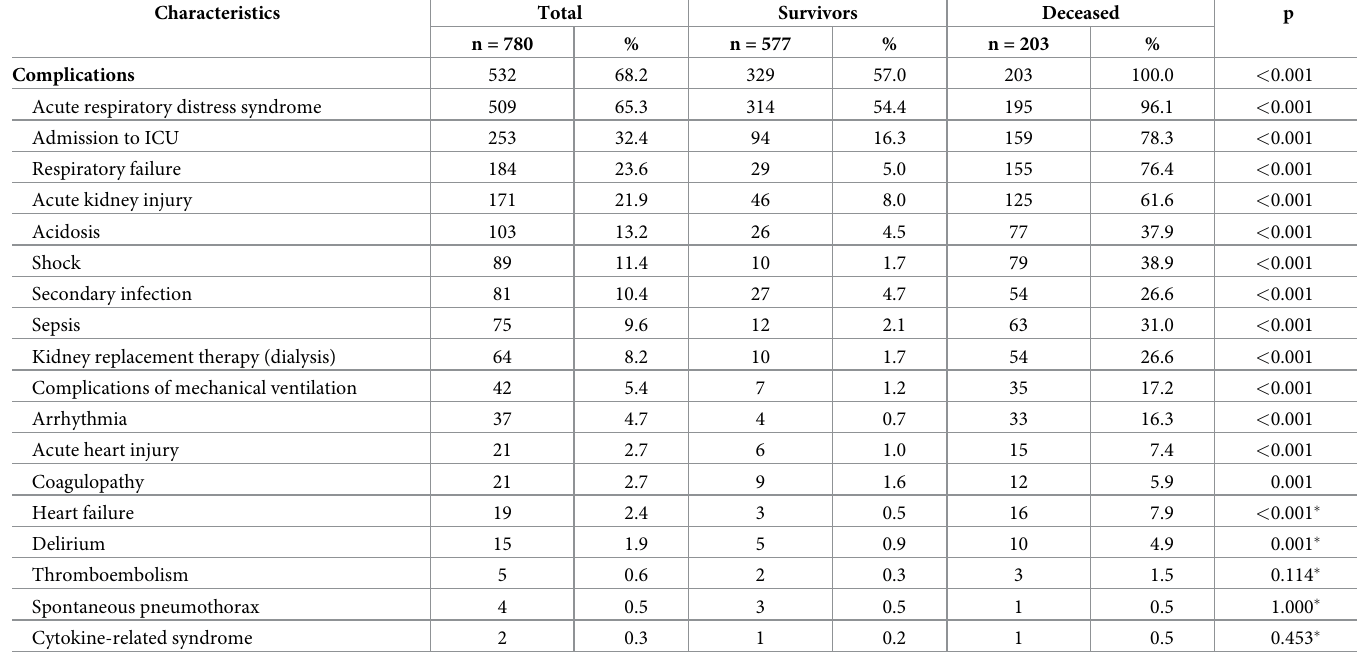
Table 3. Complications among patients who survived and died, infected with